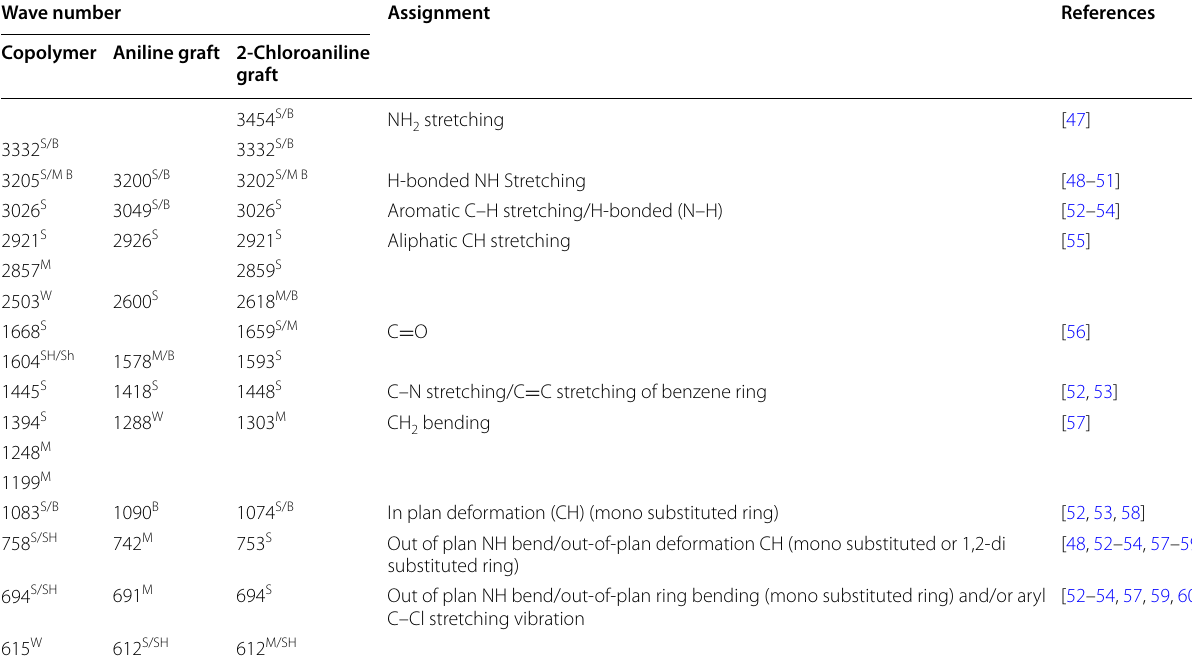
S, Strong; B, Broad; M, Medium; W, Weak; SH, Sharp; Sh, Shoulder